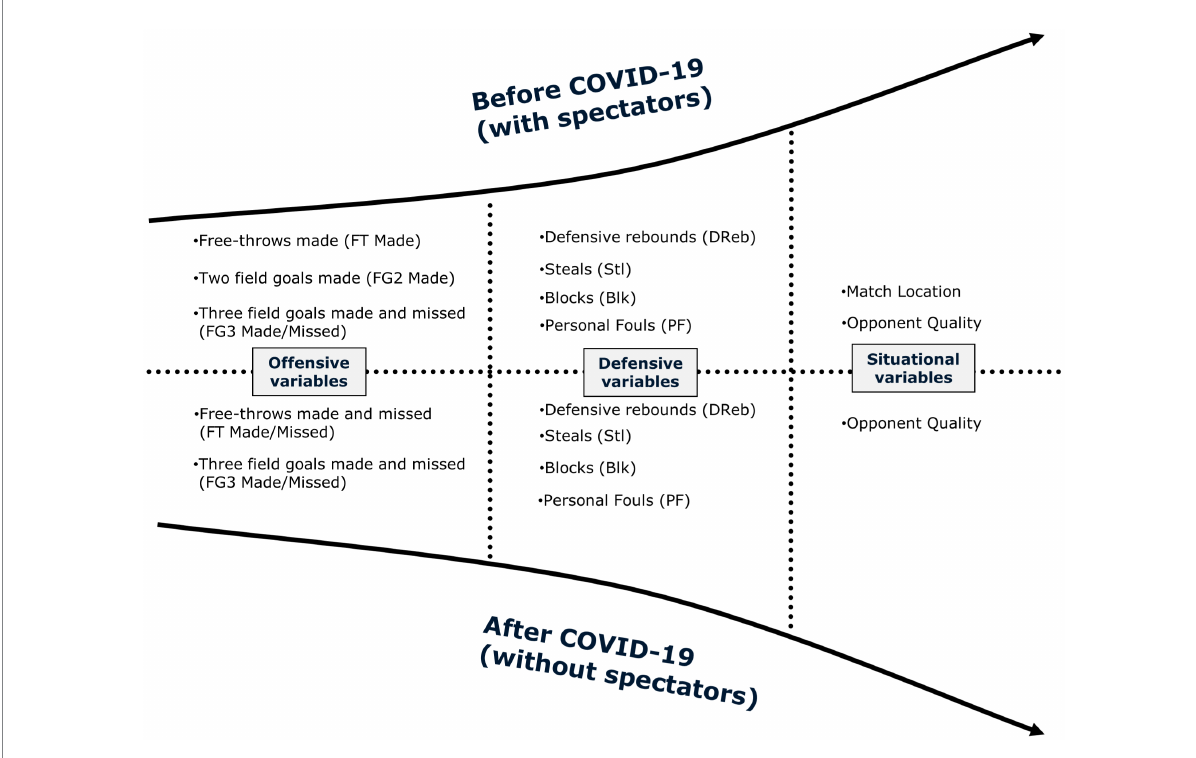
FIGURE 2 The key factors determined between winning and losing matches before and after